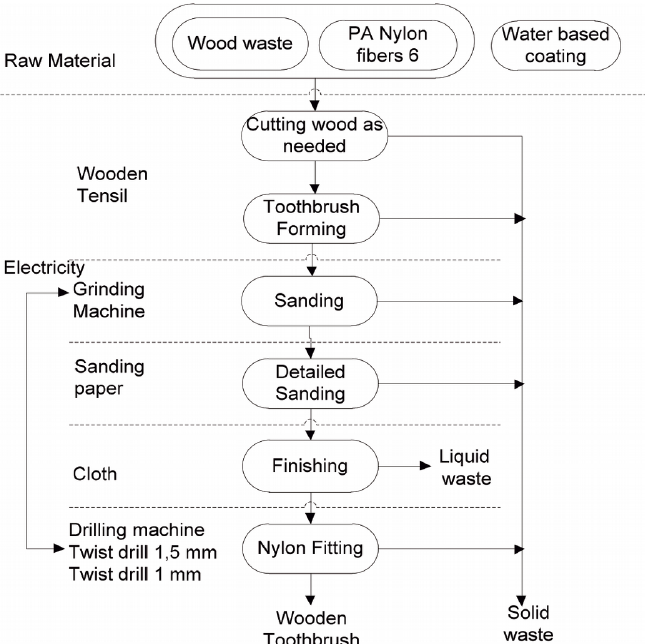
Figure 7. The production process flow of a wood waste toothbrush